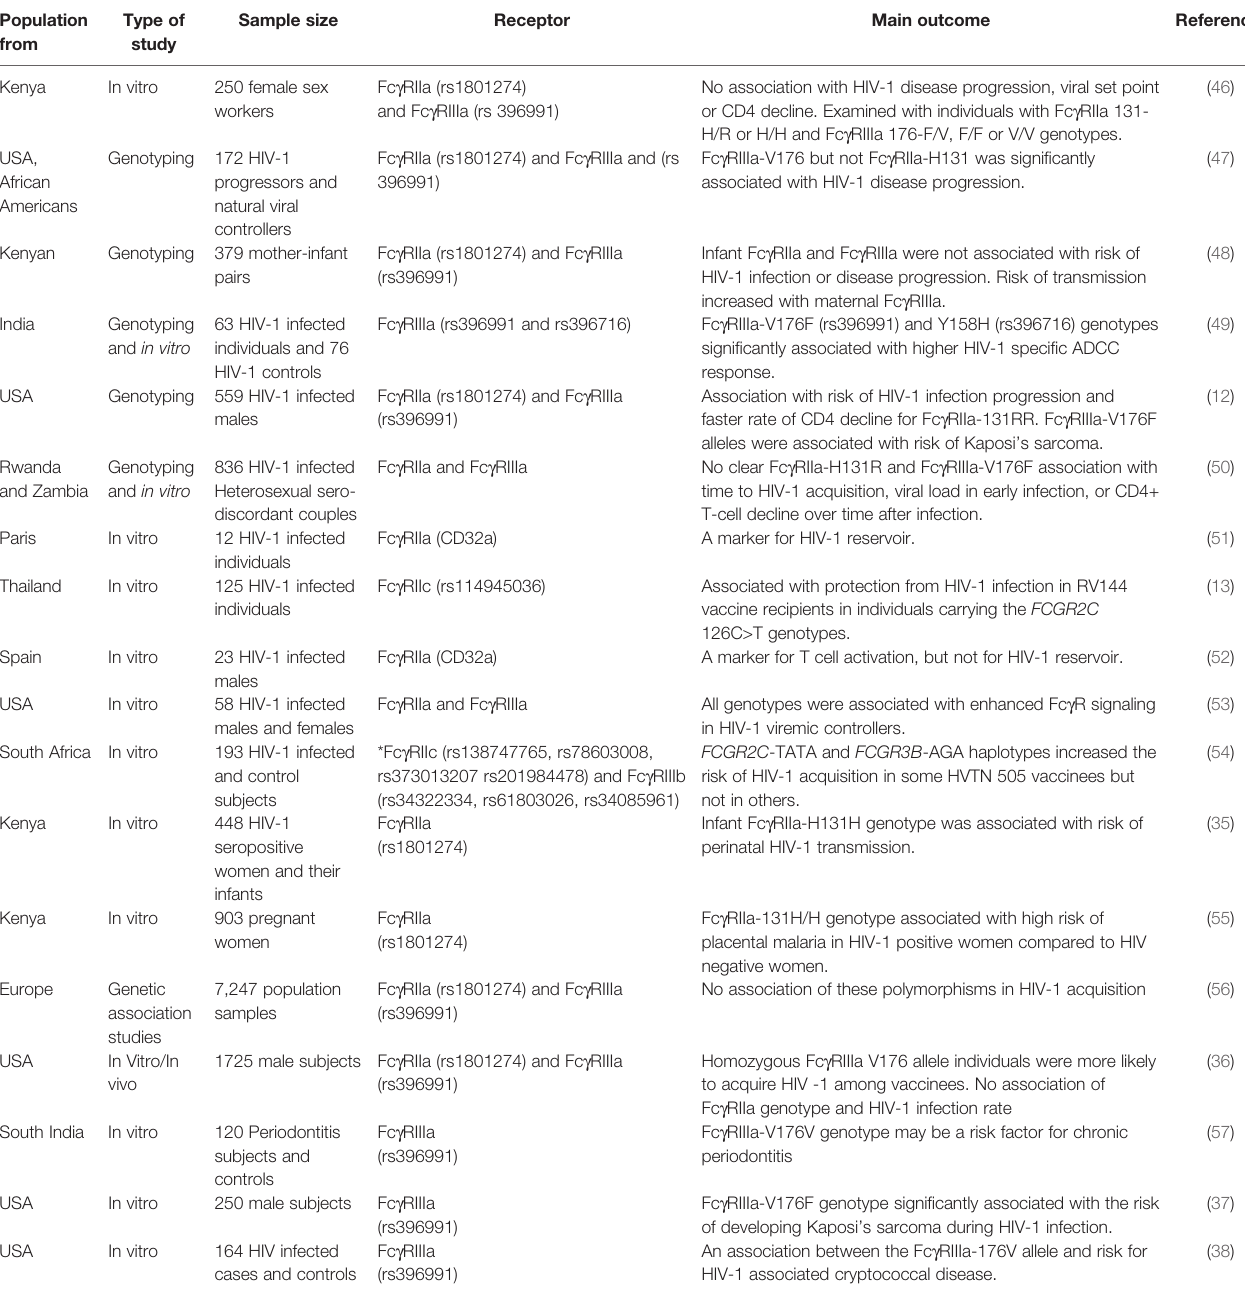
*FCGR2C-TATA haplotype (minor alleles of 4 SNPs; FCGR2C-exon06-441-C/T (rs138747765); FCGR2C-intron06-590-G/A (rs78603008), FCGR2C-intron15-403-C/T (rs373013207) and FCGR2C-intron15-433-G/A (rs201984478). FCGR3B-AGA haplotype (minor alleles of 3 SNPs; FCGR3B-5 ’ utr44-T/A (rs34322334), FCGR3B-5 ’ utr99-C/G (rs61803026), and FCGR3B-5 ’ utr222-G/A